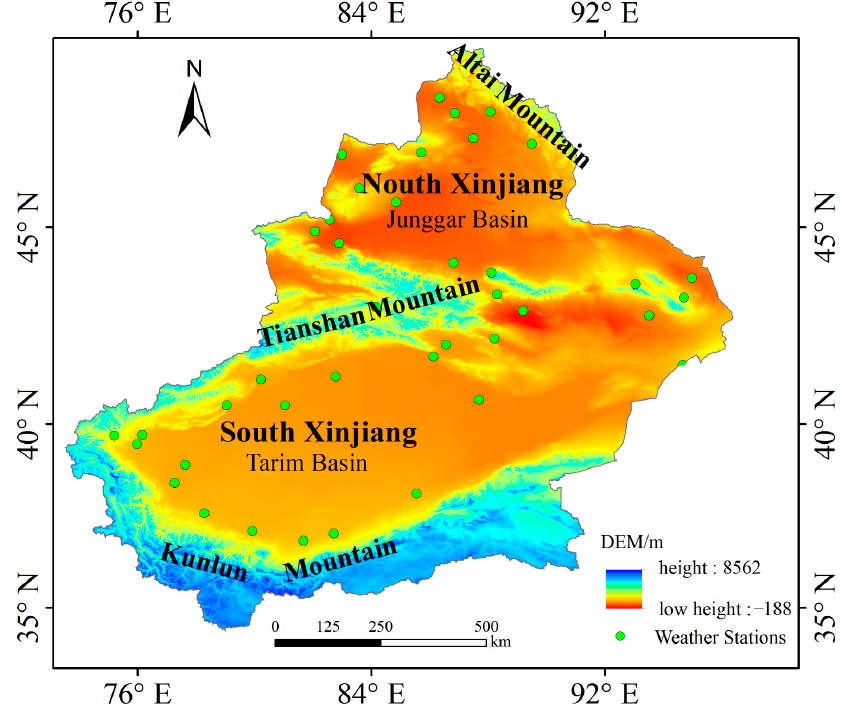
Figure 1. Location of the study area and meteorological stations.